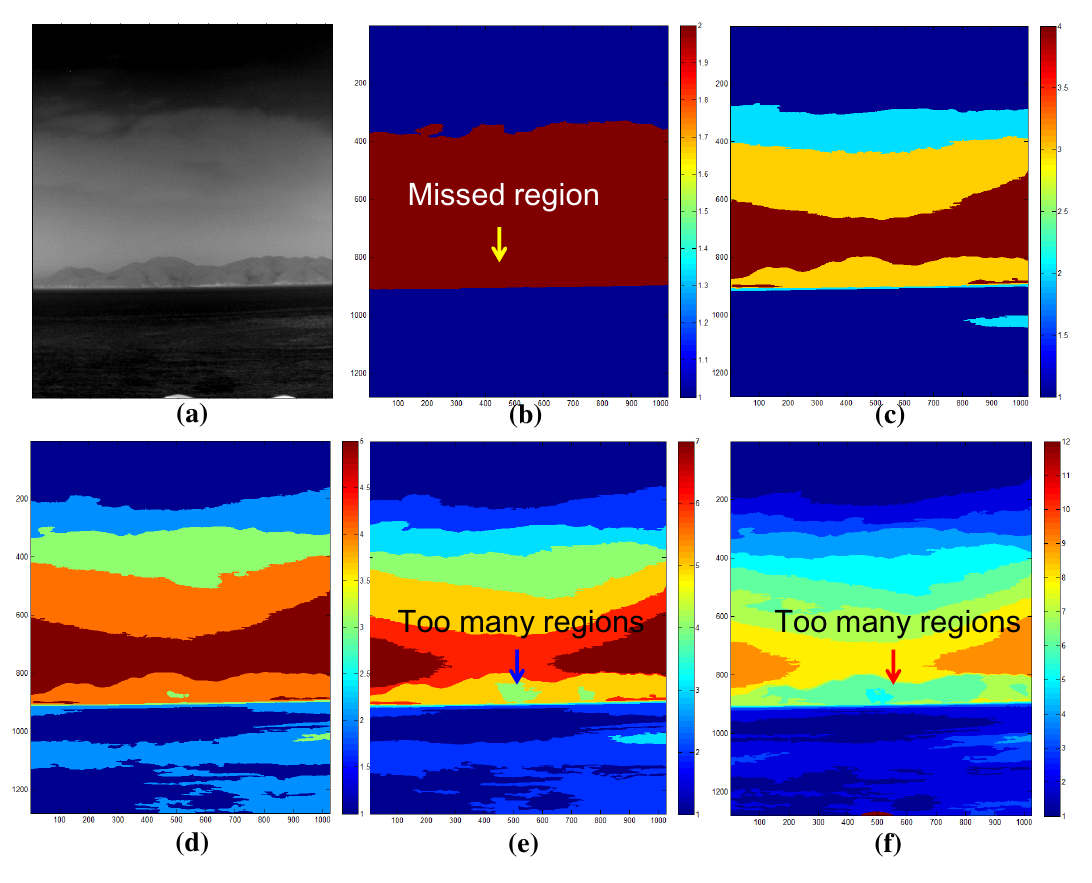
Figure 22. The effects of the parameter K in the K-means segmentation: ( a ) test image; ( b ) K = 3; ( c ) K = 5; ( d ) K = 7; ( e ) K = 9; and ( f ) K =